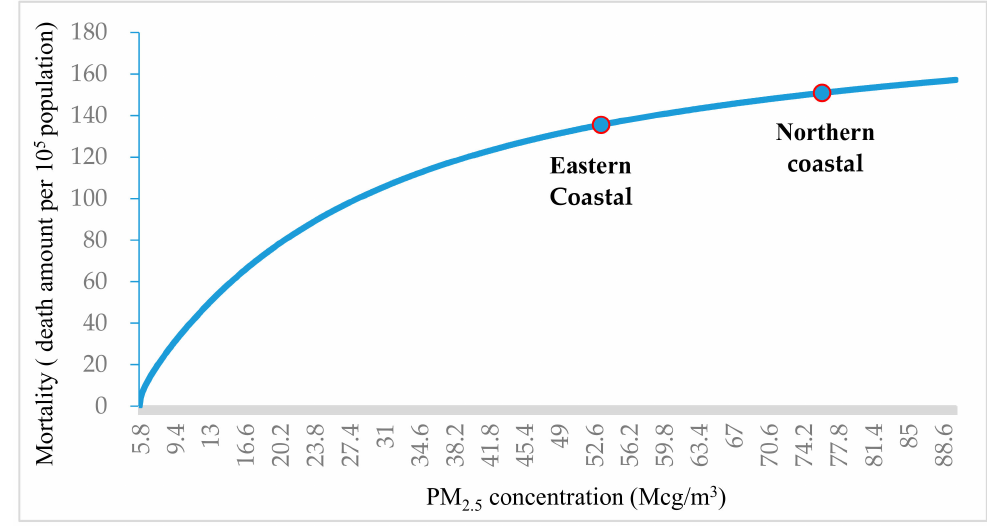
Figure 5. The relationship between PM 2.5 concentration and public